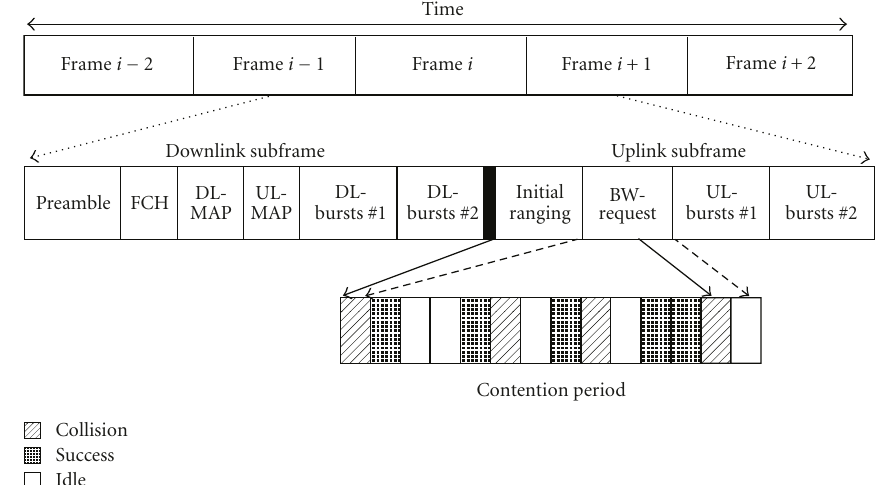
Figure 3: The channel status of IEEE 802.16 contention resolution mechanism.